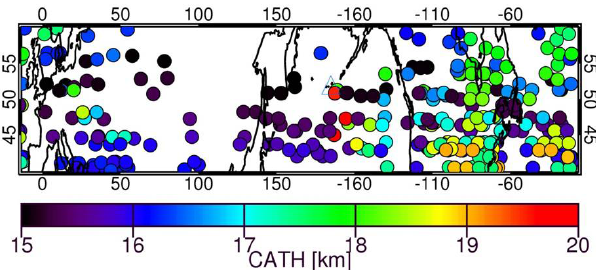
Fig. 11. MIPAS CATH in the range of 15km to 20km between 60 ◦ N and 40 ◦ N from 7 August (first Kasatochi eruption) to 31 Au- gust 2008. Location of Mount Kasatochi at 52 ◦ N, 175 ◦ W is indi- cated by the blue